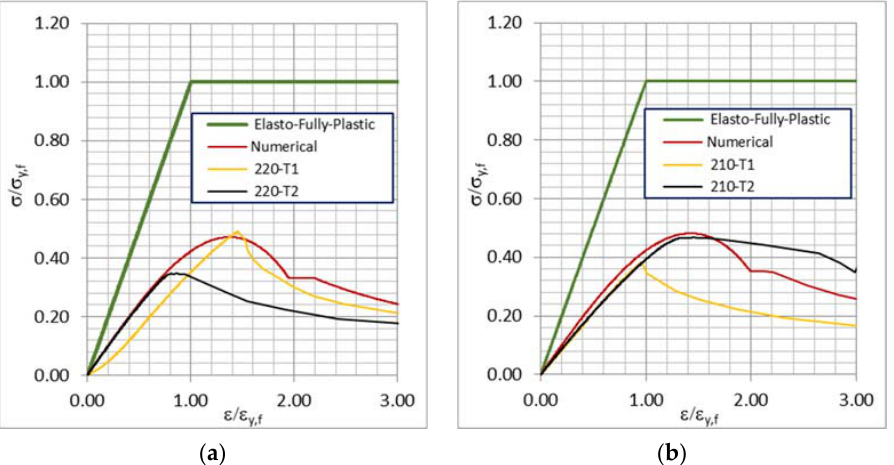
Figure 6. Stress–strain relationships of elastic–fully plastic numerical and experimental results of specimens T1 and T2 for a span of 220 mm ( a ) and 210 mm ( b ).